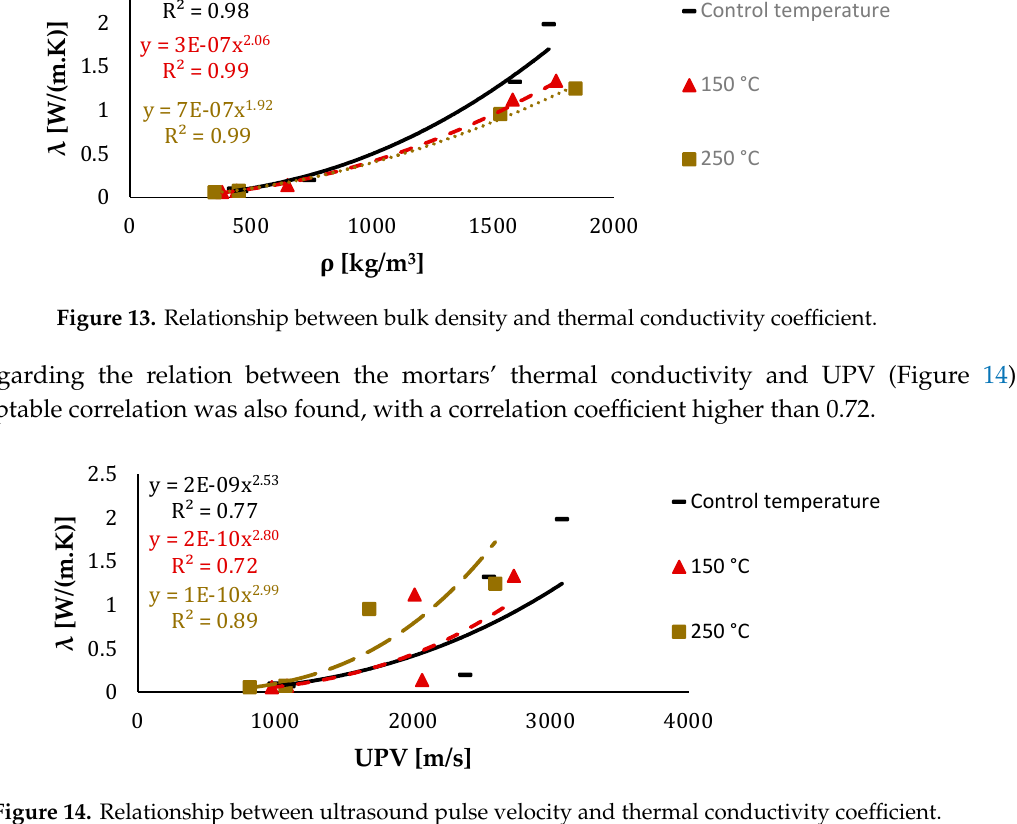
Figure 12. Relationship between ultrasound pulse velocity and compressive strength.